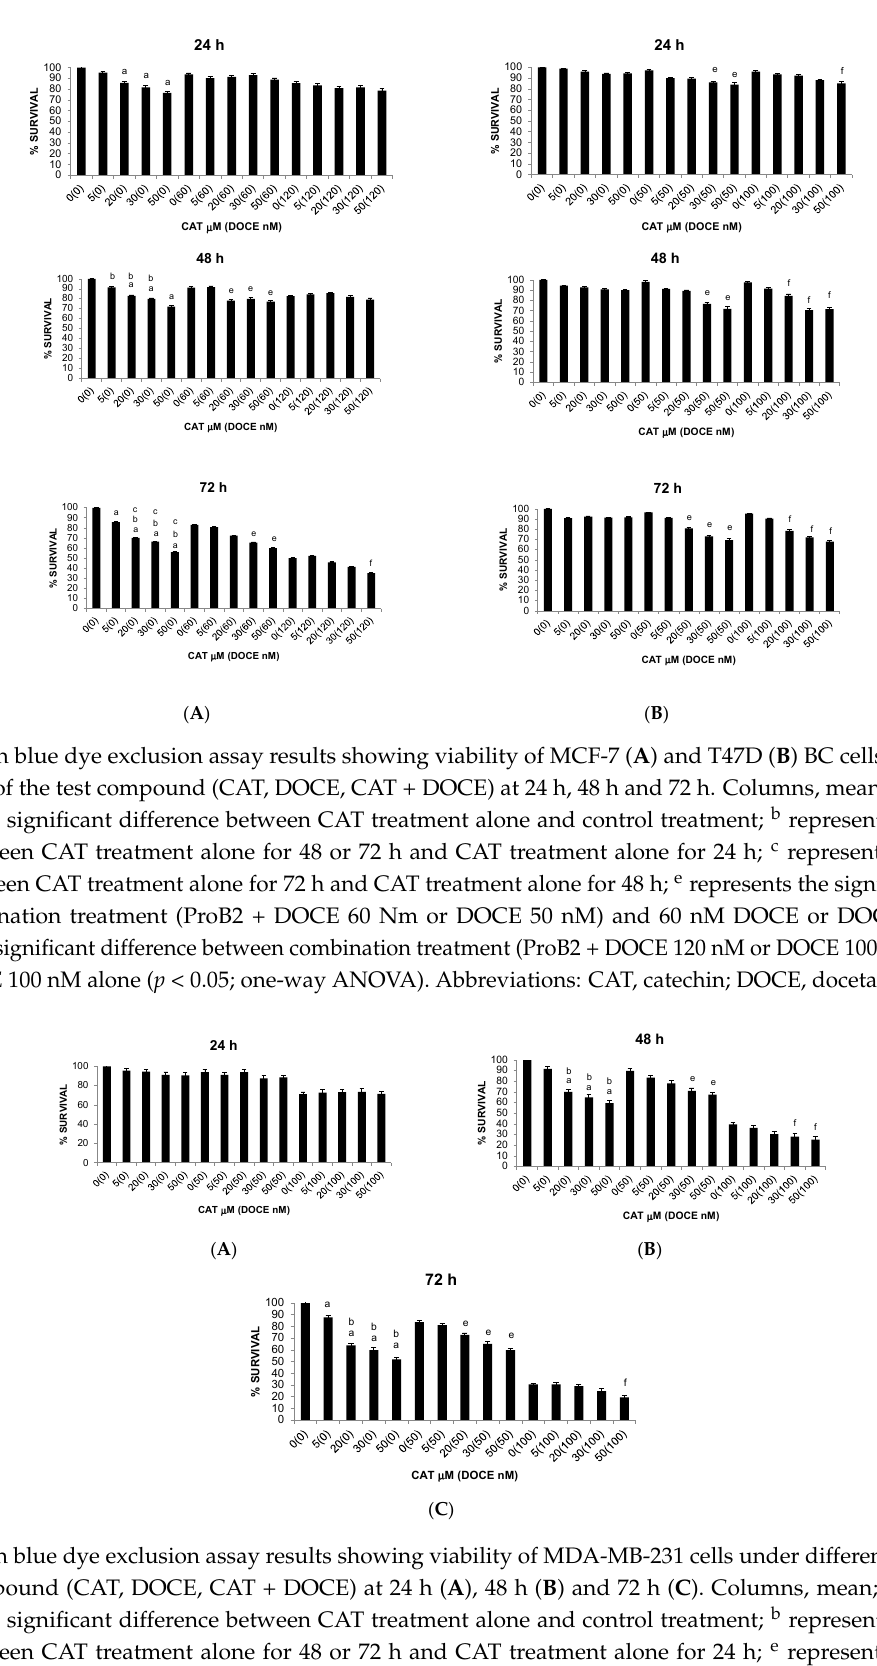
( B ) ( C ) Figure 4. Trypan blue dye exclusion assay results showing viability of MDA-MB-231 cells under different concentrations of the test compound (ProB2, DOCE, ProB2 + DOCE) at 24 h ( A ), 48 h ( B ) and 72 h ( C ). Columns, mean; bars, SE (n = 3). e represents the significant difference between combination treatment (ProB2 + DOCE 50 nM) and 50 nM DOCE alone; f represents the significant difference between combination treatment (ProB2 + DOCE 100 nM) and 100 nM DOCE alone ( p < 0.05; one-way ANOVA). Abbreviations: DOCE, docetaxel; ProB2, procyanidin B2. As shown in Figures 5 and 6, CAT significantly inhibited the proliferative activity of